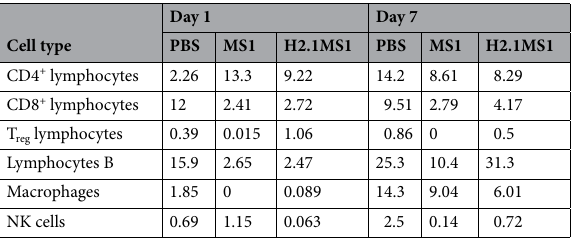
Table 1. The percentages of cell populations among CD45 + cells infiltrating the